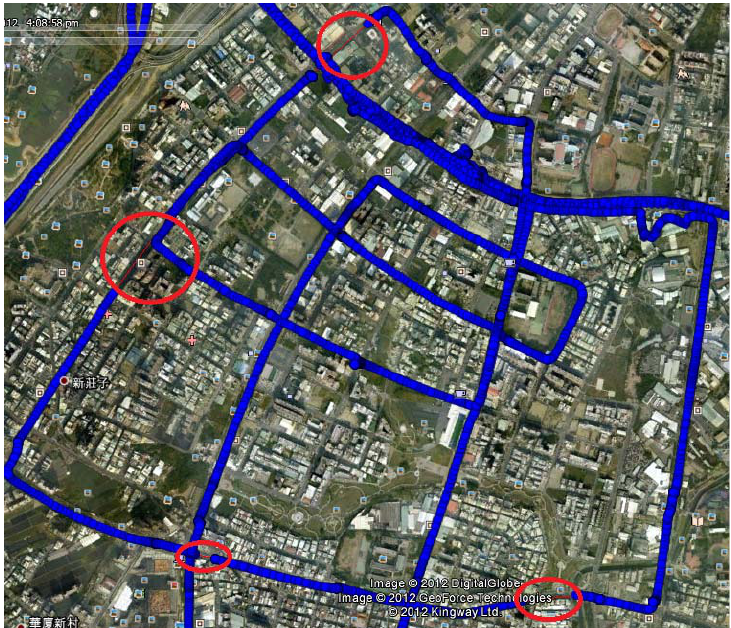
Figure 11. First test trajectory. GPS signal outages are marked by red